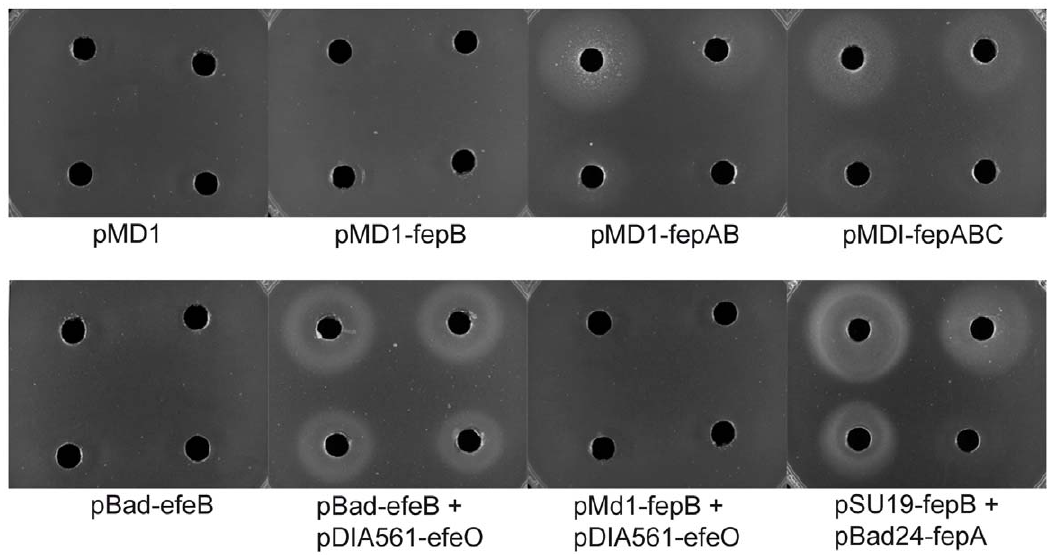
Figure 3. Heme iron acquistion plates. Growth around hemoglobin-containing wells on Petri dishes seeded with strain SET 538 carrying the indicated plasmids was photographed after 48 h incubation at 37 u C. Wells were filled with 50 m l hemoglobin at the following concentrations in m M. Top left: 50; top right: 10; bottom left: 5 and bottom right: 1.